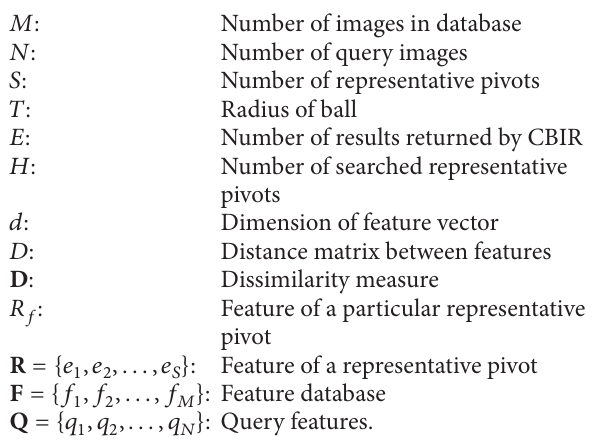
importantly, PSB obtains higher speedup than RBC on the same accuracy level. For instance, when MAP is 0.1613, PSB achieves speedup up to 4.55x, which is larger than